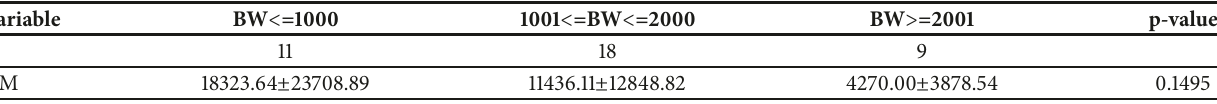
Table 4: Mean ( ± standard deviation) of donor milk according to birth weight categories.